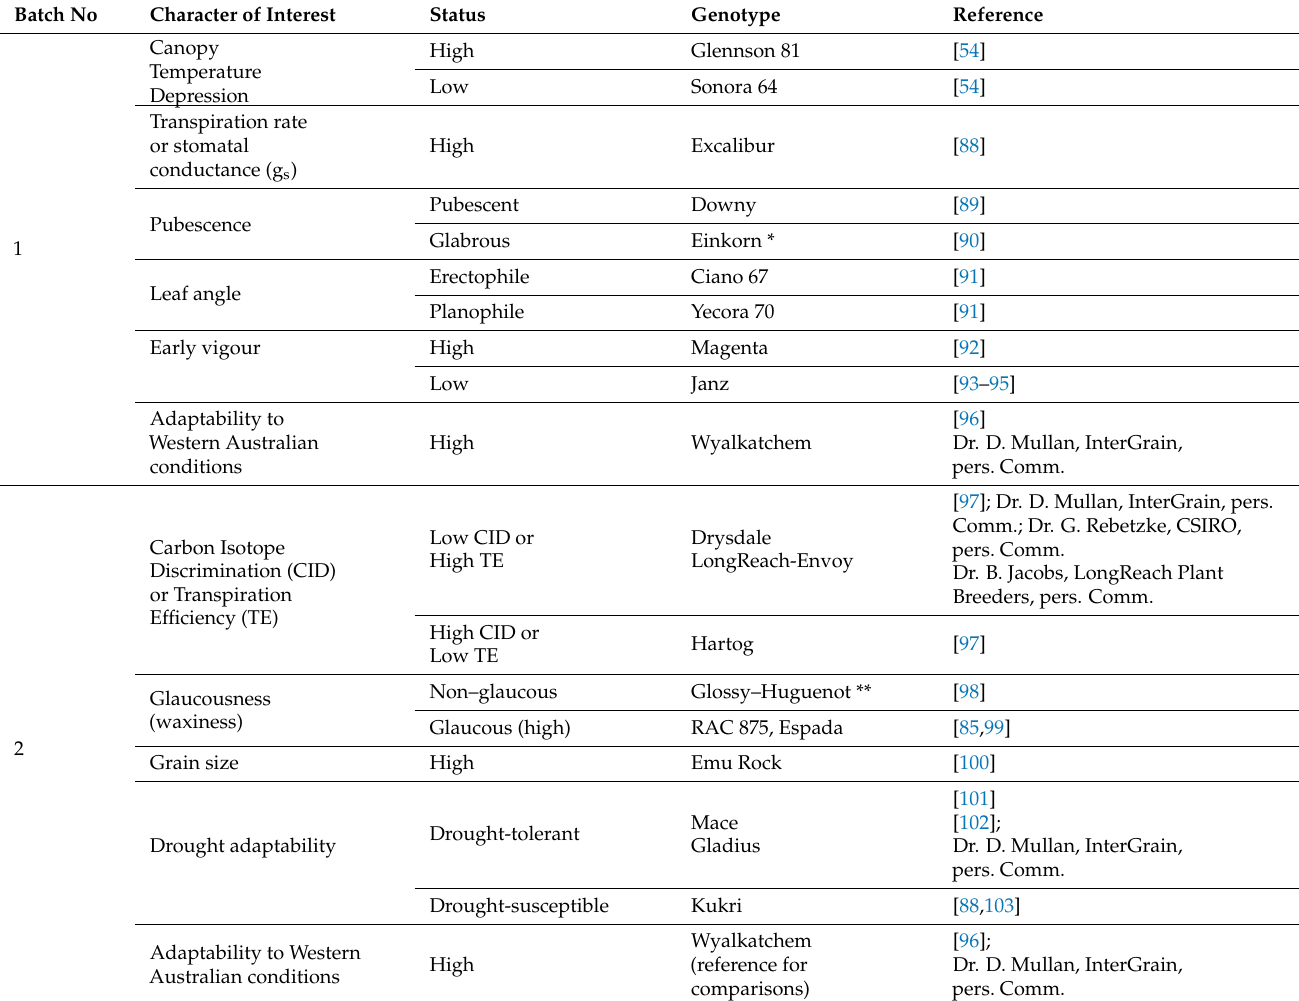
Table 6. Morpho-physiological criteria used for the selection of wheat